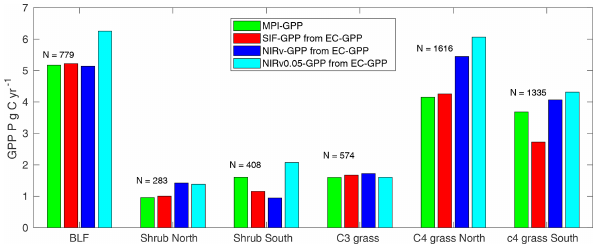
Figure 6. Comparison of aggregated MPI-BGC GPP, SIF GPP, NIRv GPP, and GPP estimated from high-resolution NIRv (NIRv0.05 GPP) for major biomes in Africa. N is the number of grid boxes of size 0 . 5 ◦ × 0 . 5 ◦ used in the